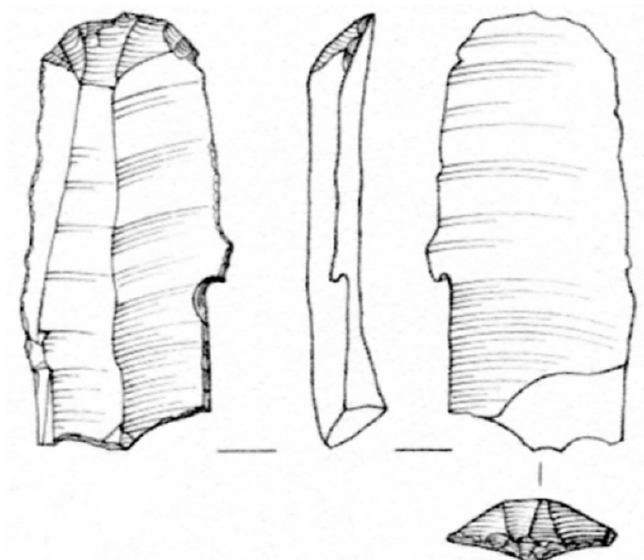
Figure 8. Blade-scraper from Howburn (CAT 822: length 38mm) with a typical acute scraper-edge and a proximal spur indicating the use of en eperon